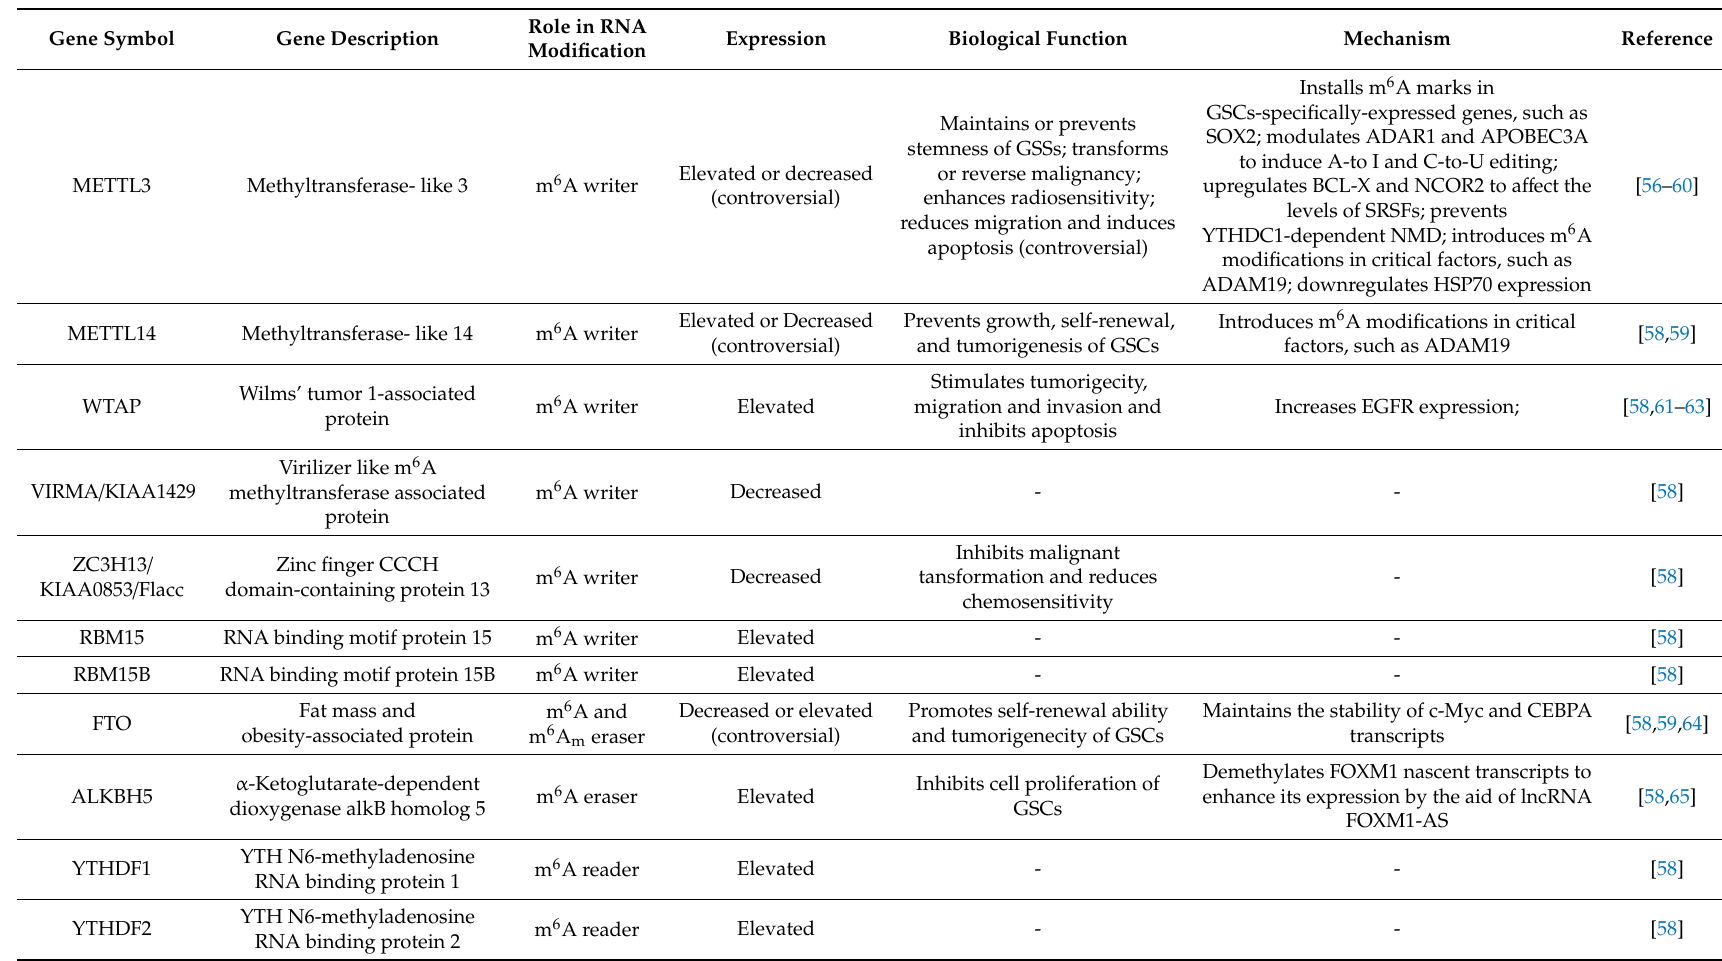
Table 1. Functions of RNA-modifying proteins (RMPs) in